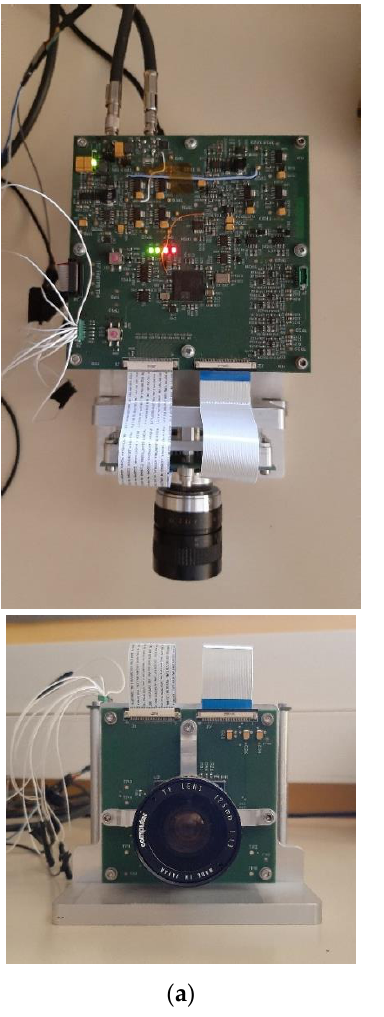
Figure 1. Pictures of the first prototype of the TuMag instrument camera: ( a ) Frontal and overhead views; ( b ) Isometric view.